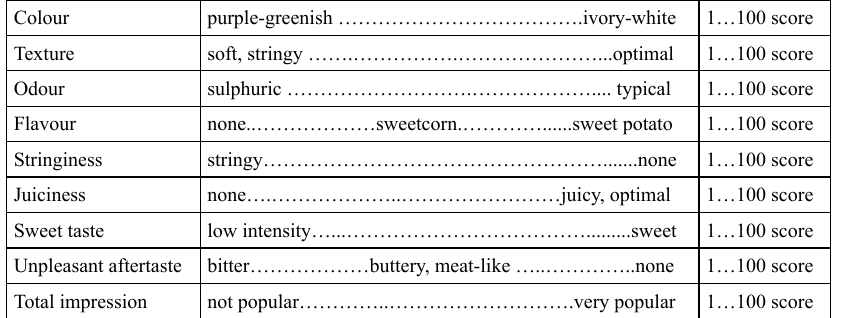
Table 3. Parameters of the organoleptic evaluation (Debrecen, 2013) Colour